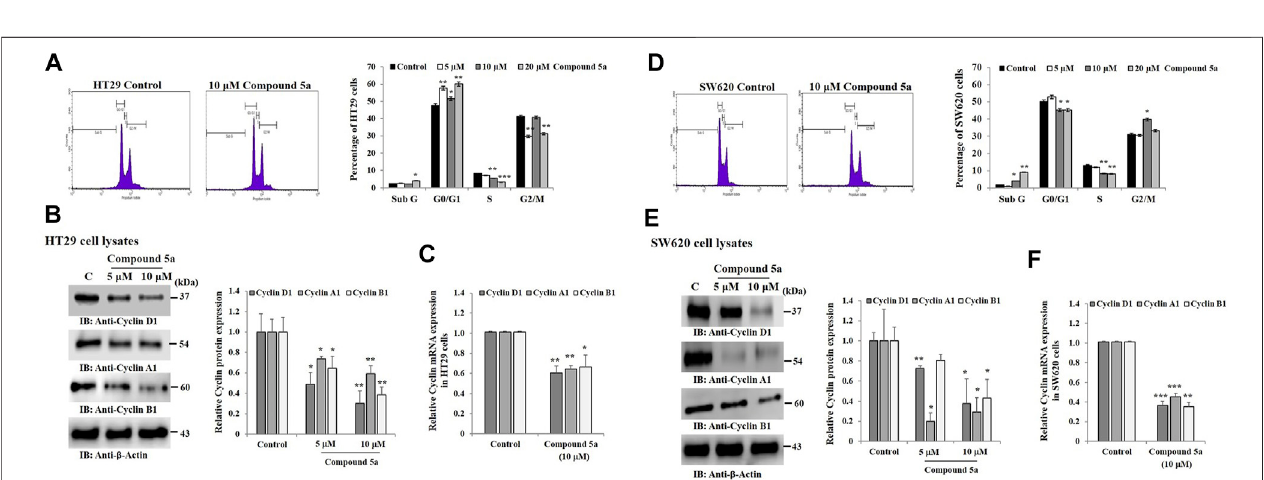
FIGURE 4 | Compounds 5a affects HT29 and SW620 cell cycle progression and downregulates Cyclins D1, A1, and B1. Representative histograms showing the cell cycle pro fi le in untreated (Control) and 10 μ M Compound 5a-treated cells. Cell cycle pro fi les were measured using fl ow cytometry after PI staining. The bar graph depicts thepercentage of HT29 (A) and SW620 (D) cells distributed insub G1, G0/G1, S,and G2/M-phases after cell exposuretovarious concentrations(5-10-20 μ M) ofCompound5a. TotalHT29 (B) andSW620 (E) celllysateswereimmunoblotted against CyclinsD1, A1,and B1usingaspeci fi cmonoclonal antibody.Bar graph indicatingtherelativeCyclinsproteinexpression level,related totheloadingcontrol ß -actin.BargraphshowingtherelativemRNAexpression levelofCyclinsinHT29 (C) and SW620 (F) RNA extracts related to the internal control GAPDH. Data are shown as mean ± SD ( n = 3). * p < 0.05, ** p < 0.01, and *** p < 0.001 vs . Control.